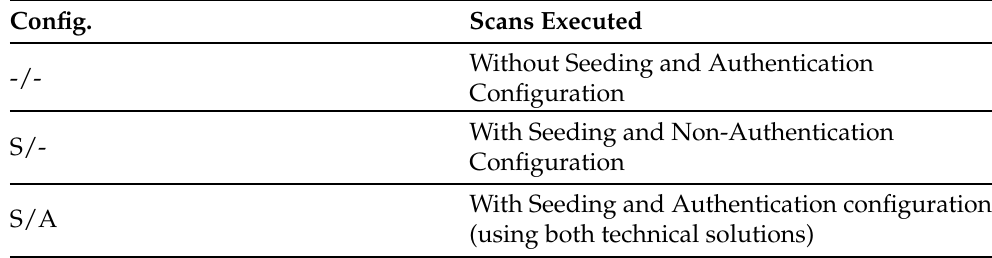
Table 8. Configurations used during the